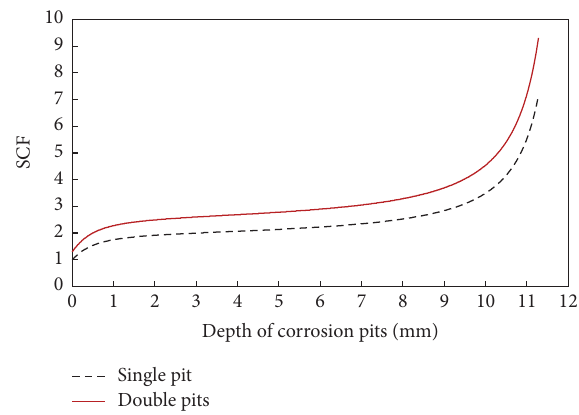
Figure 9: Modified SCF changing with the depth of corrosion pits ( 𝑑 = 9mm).